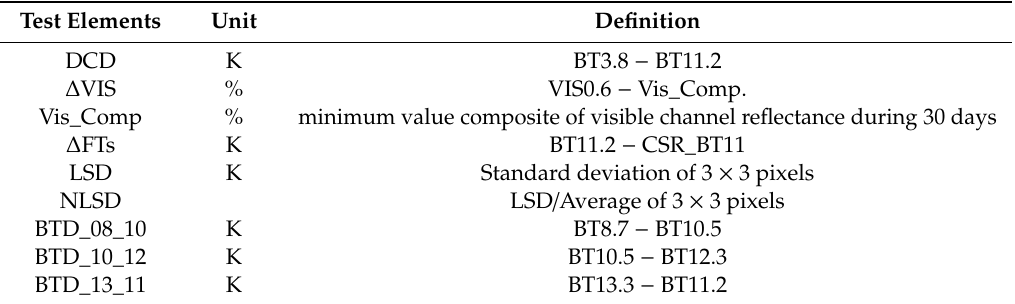
Table A1. Definition of each test